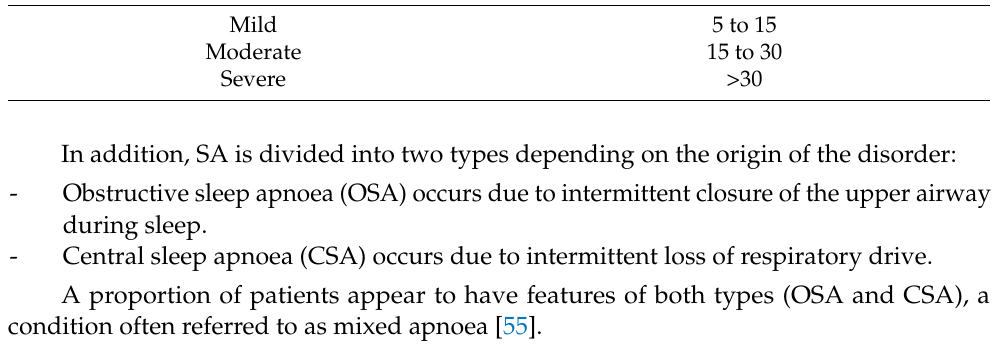
Table 3. Classification of apnoea-hypopnea index (AHI) for sleep apnoea classification [54]. Sleep Apnoea